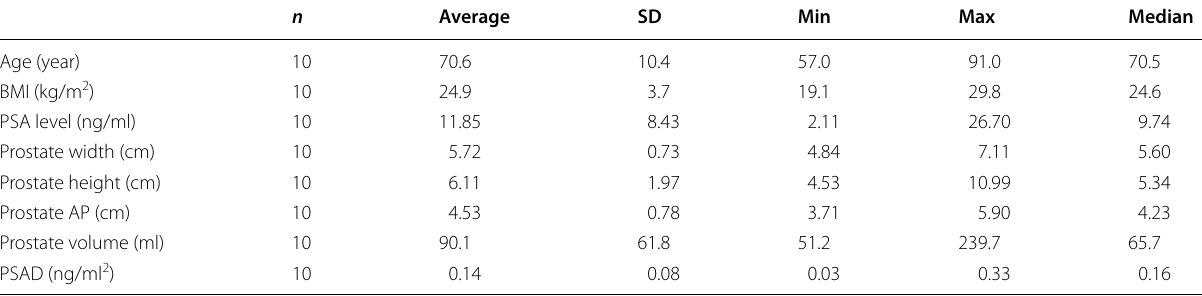
Table 3 Patient